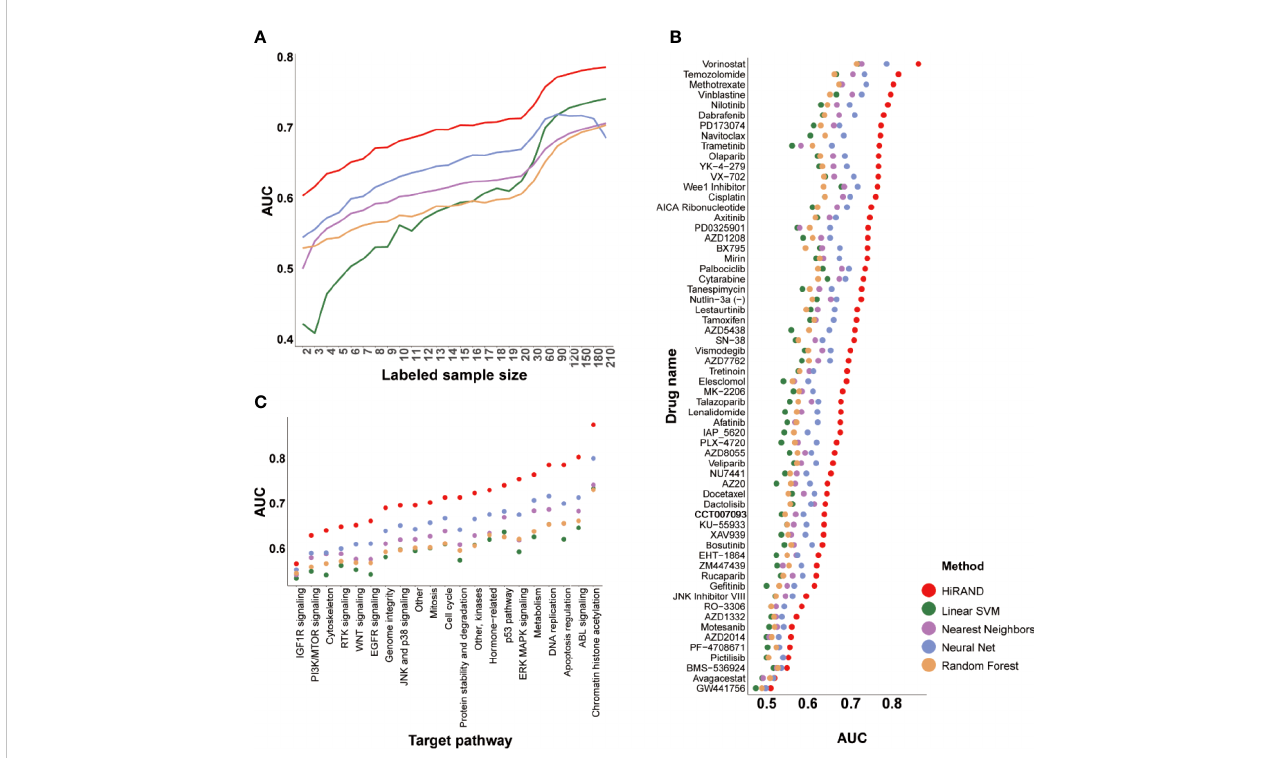
FIGURE 3 The predictive performance of HiRAND on drug response data. (A) The plot showed the average model AUC across all of the drug response models trained by different labeled samples. We considered the number of labeled samples from 2 to 20 as the fi rst test level and from 30 to 210 as the second test level. The AUC of HiRAND was displayed separately for each drug (B) and target pathway (C)